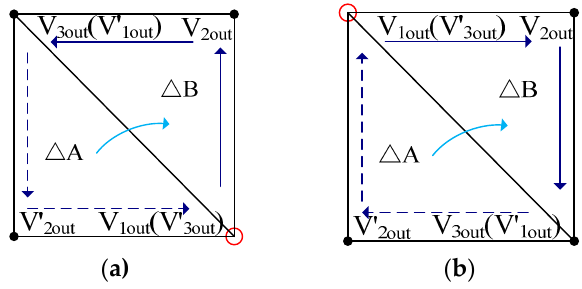
Figure 11. Switching paths in the third kind of quadrangle, ( a ) state 1; ( b ) state 2.